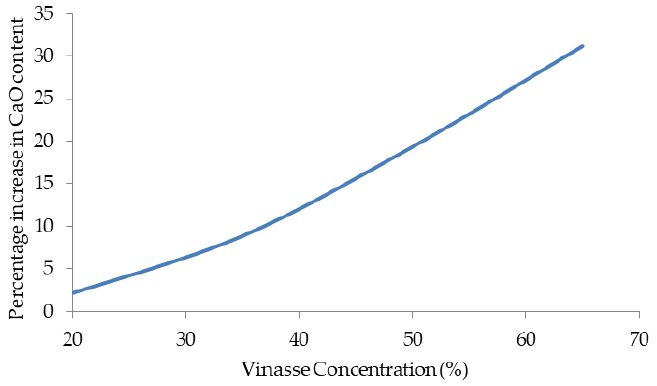
Figure 2. Percentage of CaO content as a function of vinasse concentration.